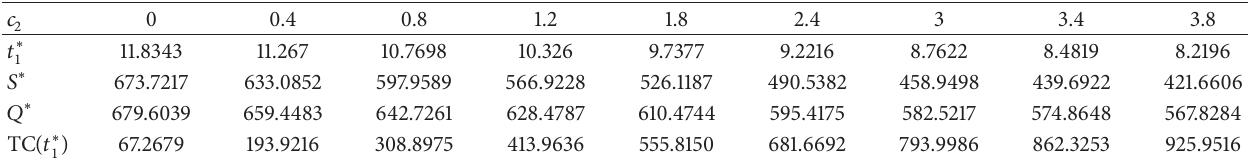
Table 5: The sensitivity of 𝑐 2 for the model in Example 1.